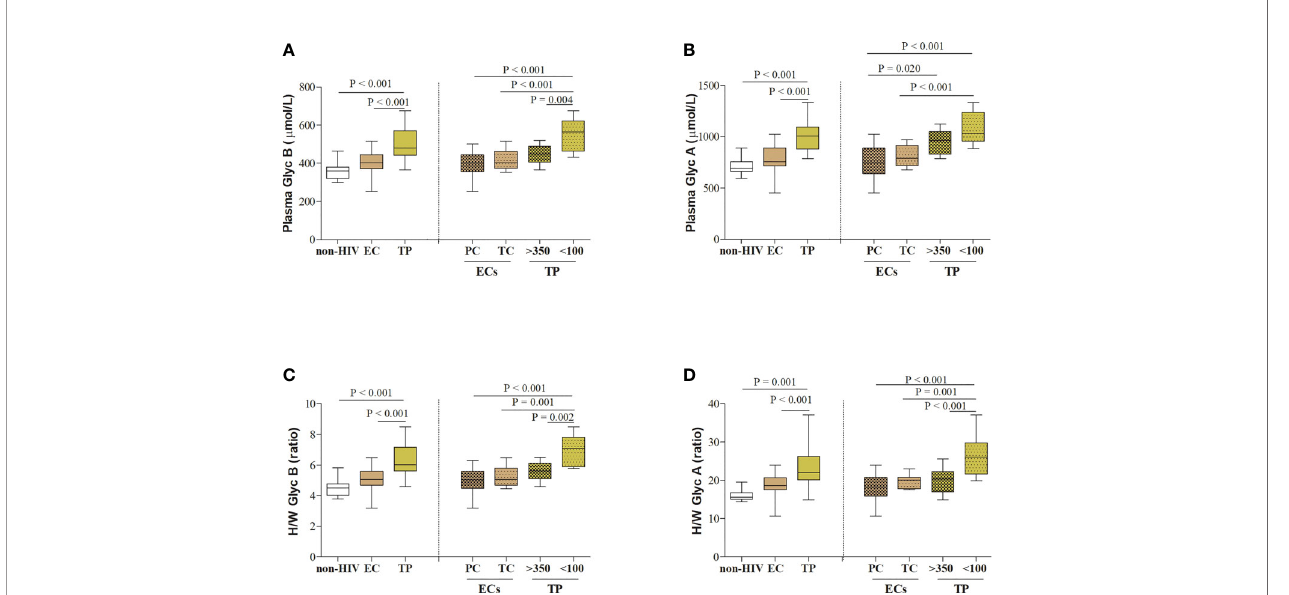
FIGURE 2 | Serum acute-phase glycoprotein pro fi le in PLWH. (A) Serum glycoprotein B and (B) glycoprotein A concentrations, and (C) height/width ratios for glycoprotein B and (D) glycoprotein A are represented for HIV-elite controllers (ECs) and HIV-typical progressors (TPs) and healthy HIV-negative individuals (n=11), matched by sex and age. PLWH in each different cohort of HIV studies (PLWH-EC and PLWH-TP) were also classi fi ed according to the viral control or the pre-cART CD4+ T-cell counts, respectively. For PLWH-EC, data for PCs corresponded to median values from at least two different time points (T0), and data for TCs corresponded to the closest moment to the loss of viral control. For PLWH-TP, data from T0 corresponded to the moment when subjects were enrolled in the study and started their fi rst ART (pre-ART). Thus, PLWH-TP were classi fi ed in subjects presenting nonsevere immune damage (>350 CD4+ T-cells) or subjects with severe immune damage (<100 CD4+ T-cells). Statistical analysis was performed by one-way ANOVA followed by Bonferroni ’ s post hoc test. Data are re-presented as boxes and whiskers (min to max values). EC, elite controller; Glyc, glycoprotein; H/W, height/width glycoprotein ratio; non-HIV, healthy HIV-negative individuals; PC, persistent controller; PLWH, people living with HIV; TC, transient controller; TP, typical